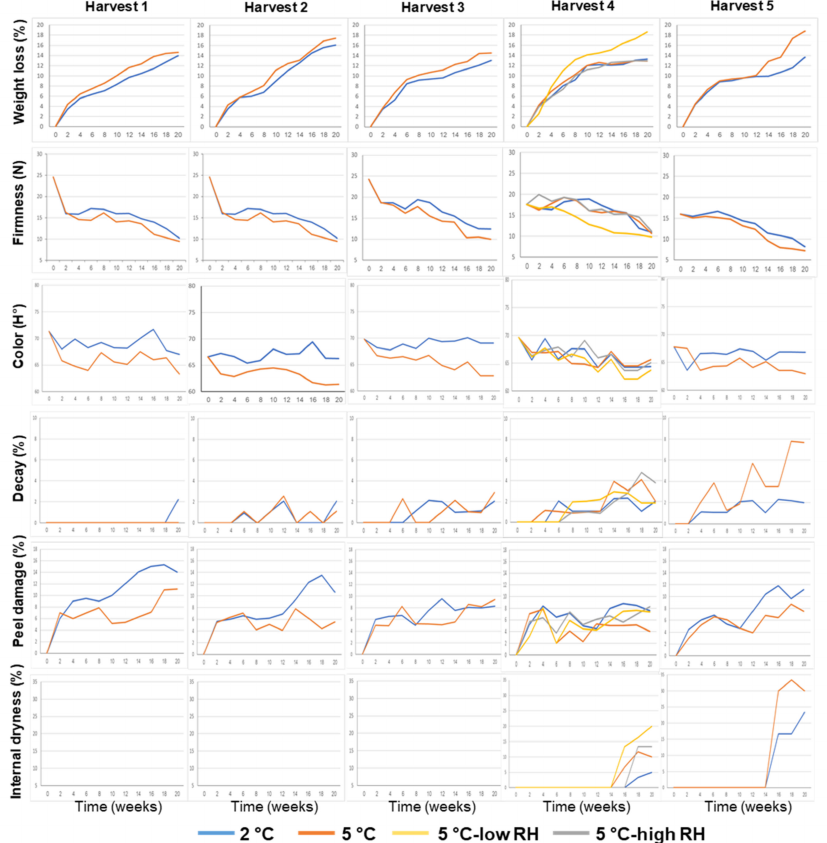
Figure 1. Effects of various preharvest and postharvest features on the postharvest storage quality of ‘Valencia’ oranges harvested from five different orchards. The harvest times, yields, tree age, and rootstocks of the different orchards are presented in Table 1. The postharvest features included the storage temperature (2 ◦ C or 5 ◦ C) and storage RH level (70%, 90%, or 95%). Fruit quality was evaluated every 2 weeks after 1 additional week of storage under shelf conditions (at 20 ◦ C) for a period of 20